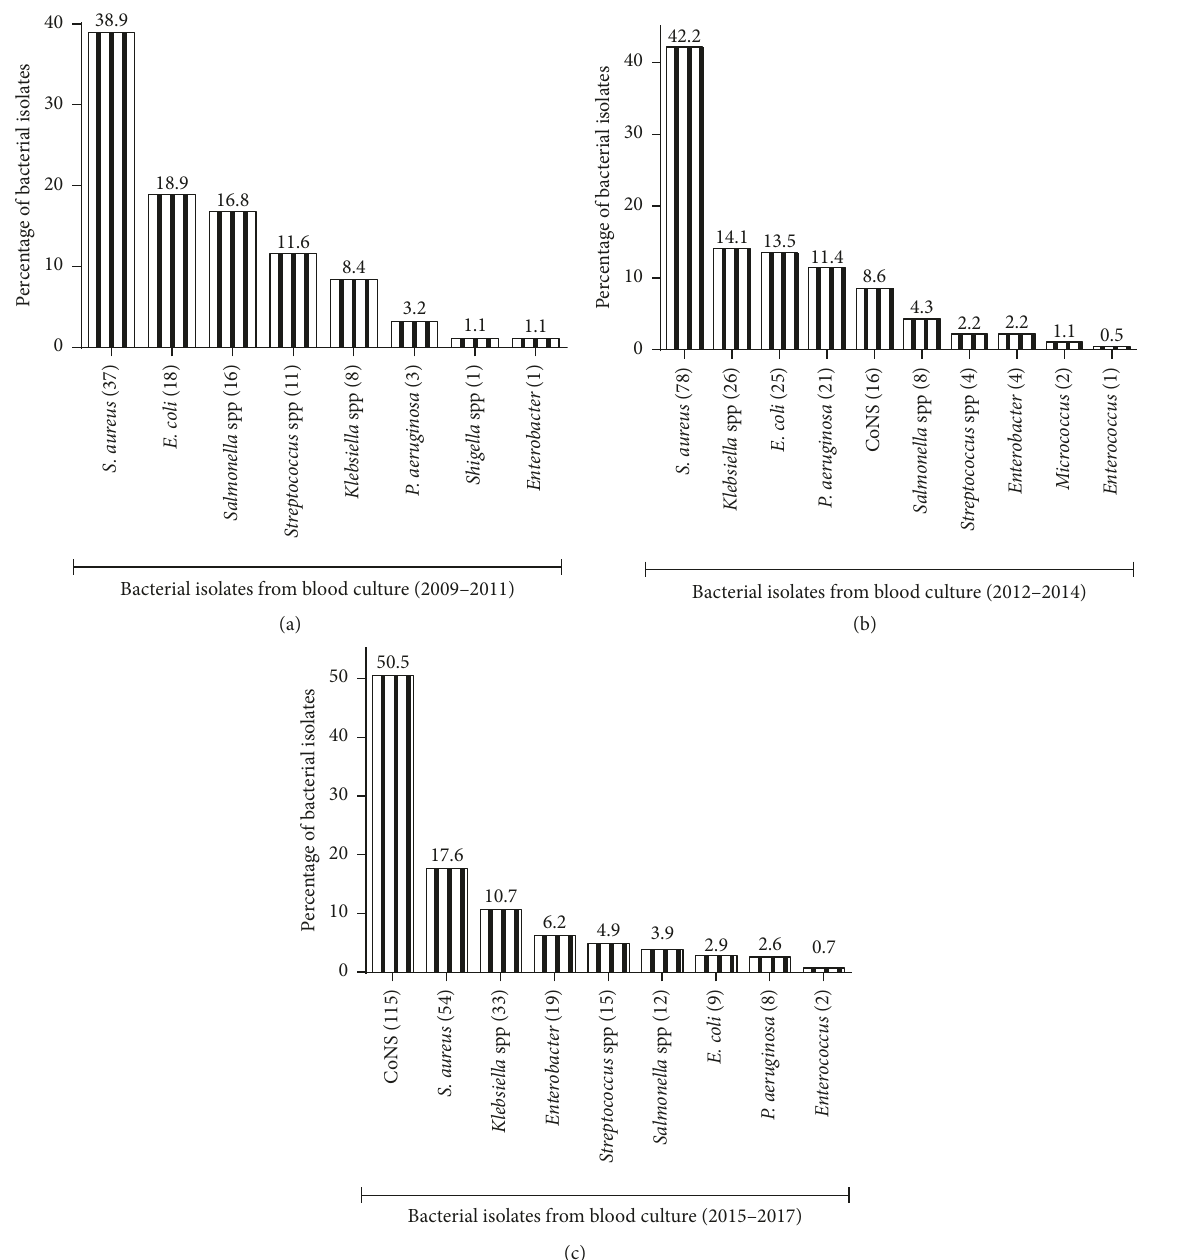
Figure 1: Pattern of bacterial isolates from blood culture at St. Dominic Hospital in Akwatia: (a) 2009–2011, (b) 2012–2014, and (c) 2015–2017. Absolute numbers of isolates are in